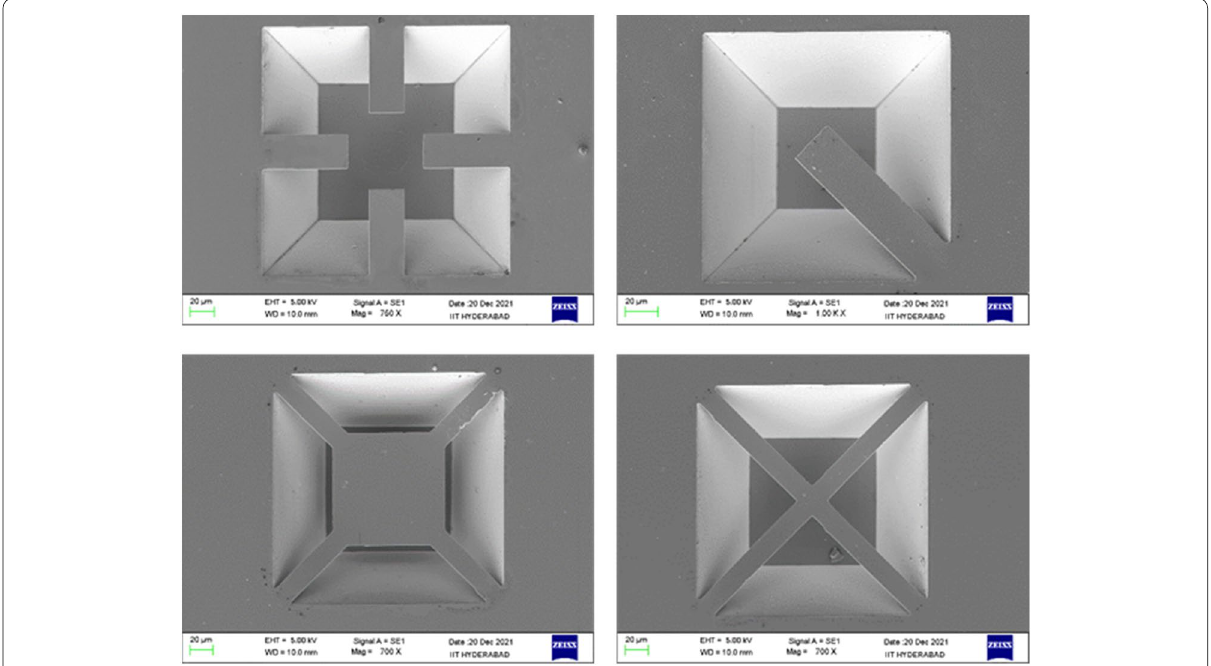
Fig. 6 SEM images of fabricated structures in NH 2 OH-added